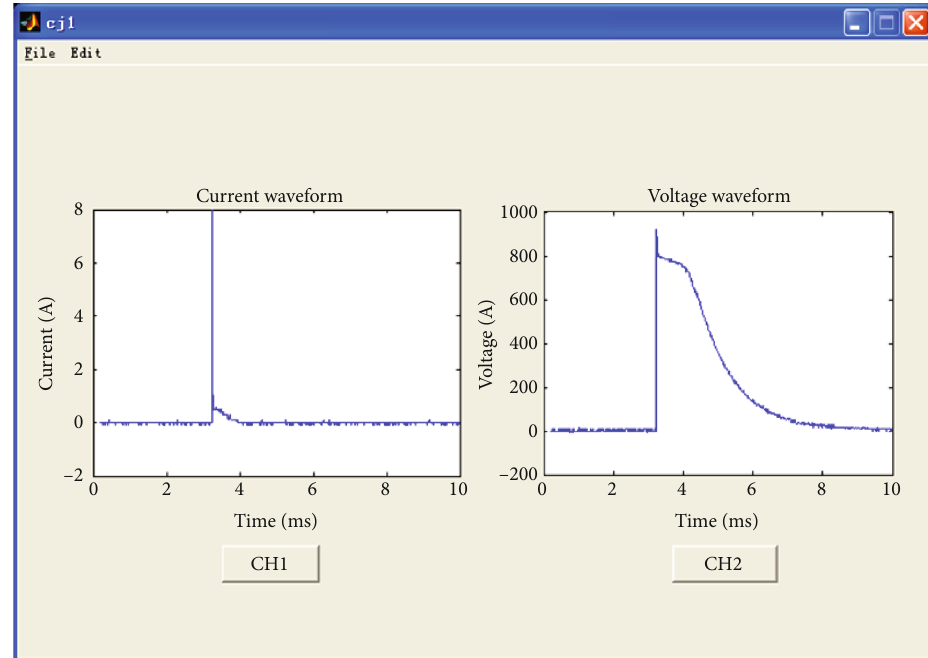
Figure 7: Response waveform of TVR20621 to wide